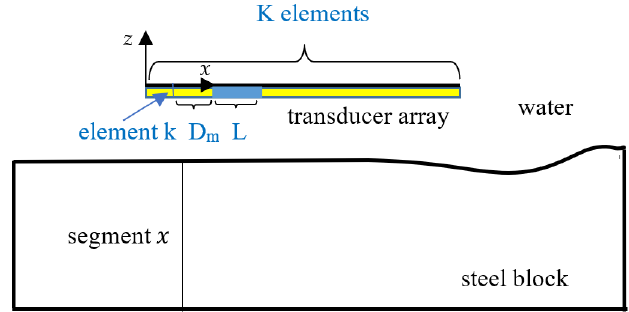
Figure 5. A schematic of